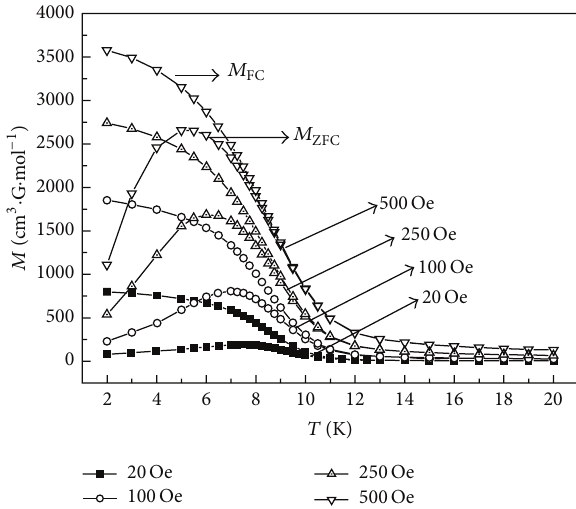
Figure 11: 𝜒 󸀠 (𝑇) and 𝜒 󸀠󸀠 (𝑇) curves of AC magnetic susceptibility of the compound with different